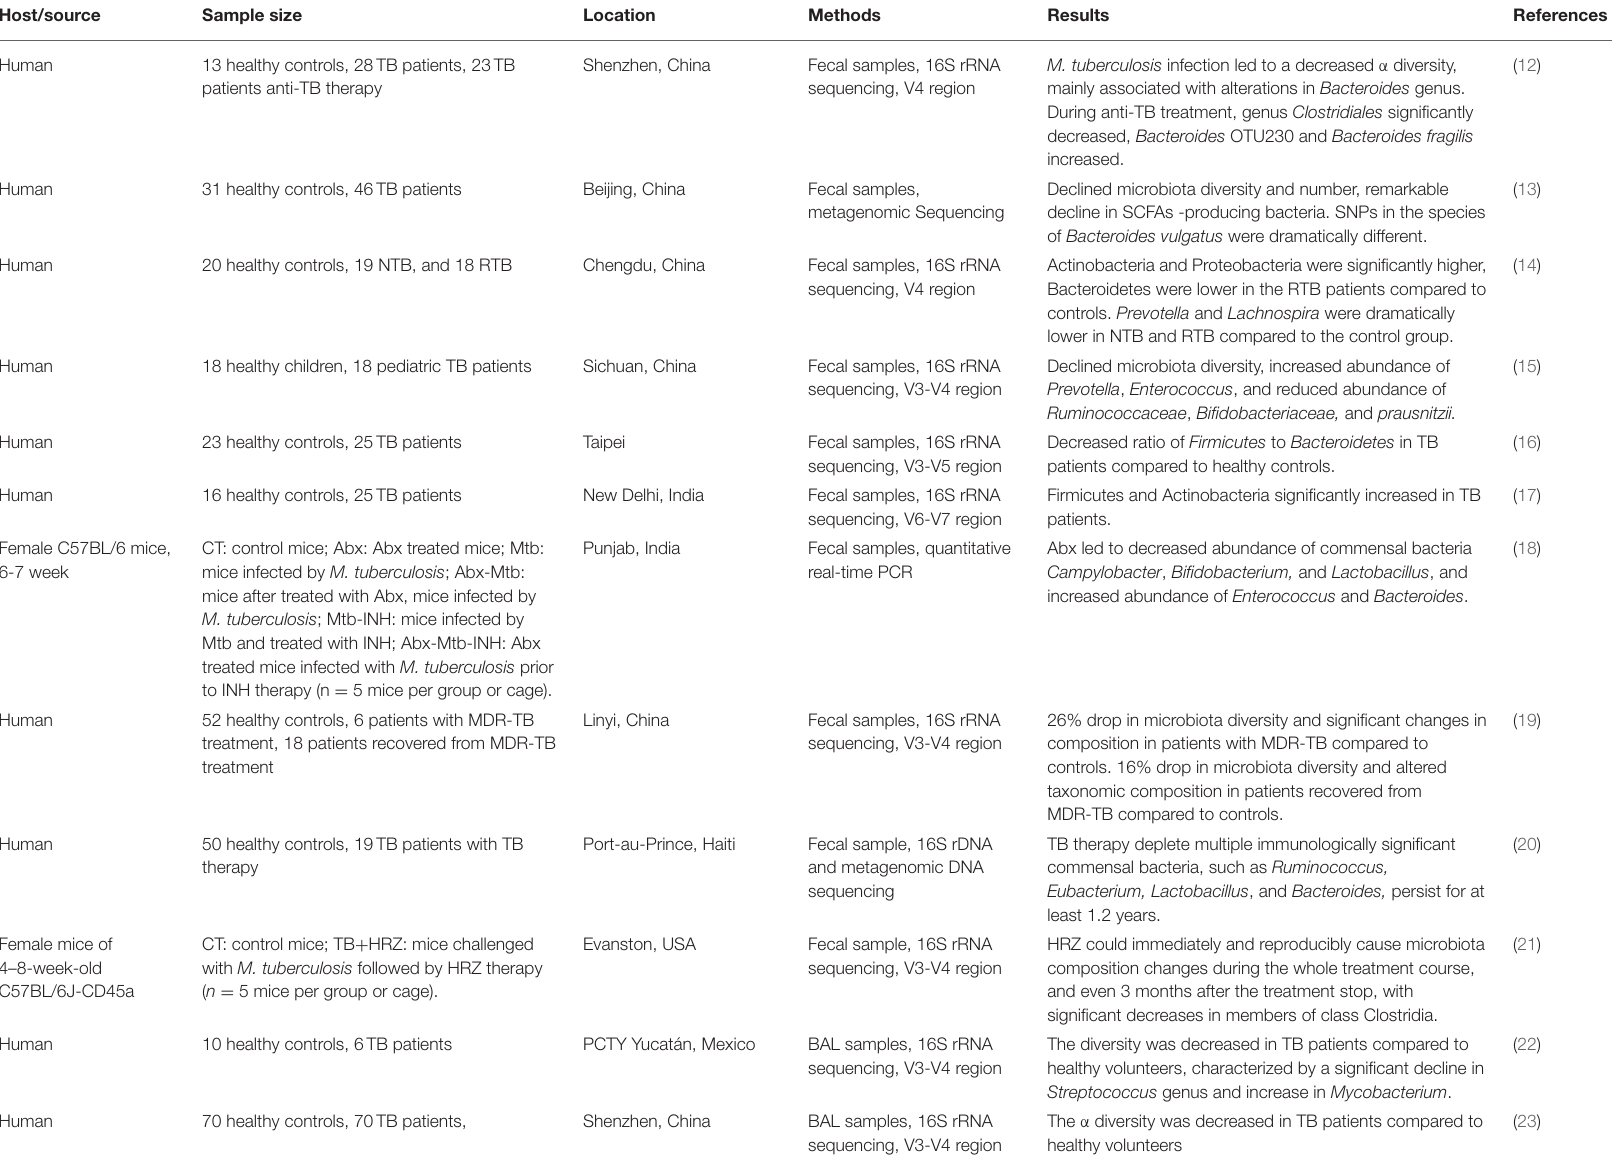
TABLE 1 | Example of studies designed to determine the relationship between gut microbiota and